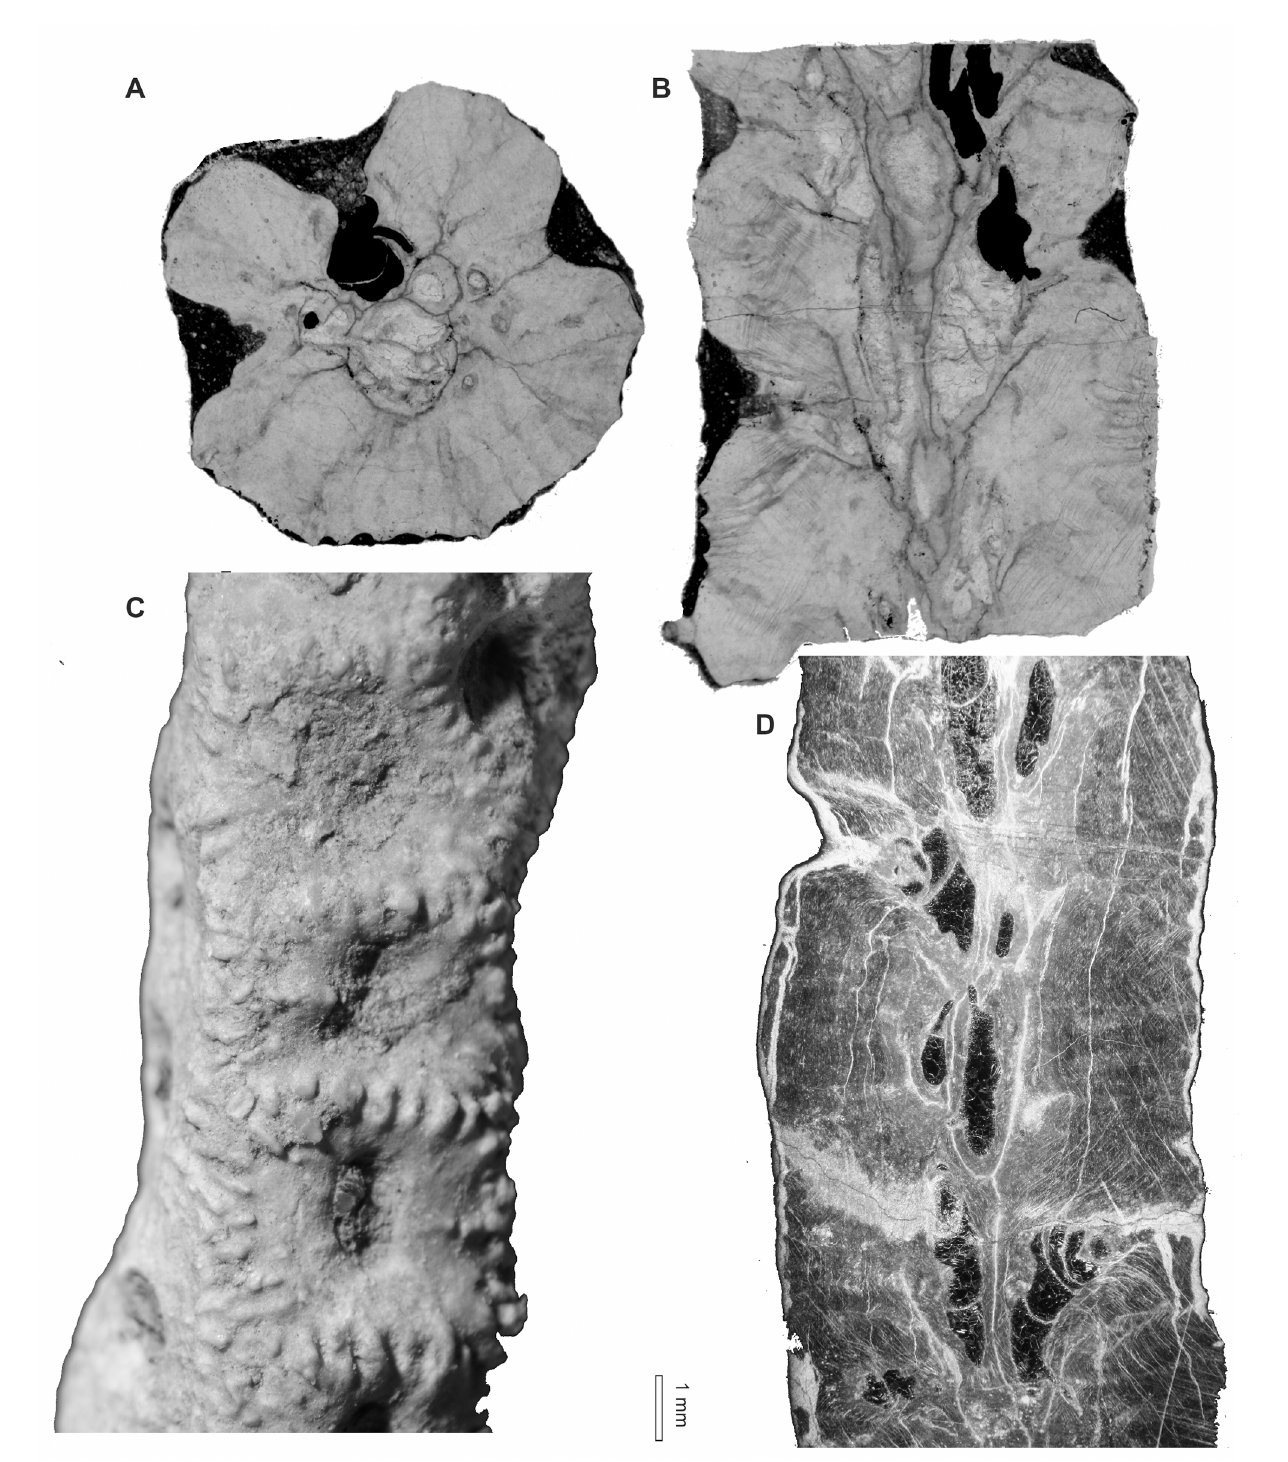
Fig 7. Thamnoptychia mistiaeni sp. nov. from Kowala Quarry, lithological sets J or K, Upper Famennian. (A) Transverse section through a branch. (B) Longitudinal section through a branch. Specimen GIUS 3619 KF 049, holotype. (C) External view of a branch. Specimen GIUS 3619 KF 090a. (D) Longitudinal section through a branch. Specimen seen in dark field, GIUS 3619 KF